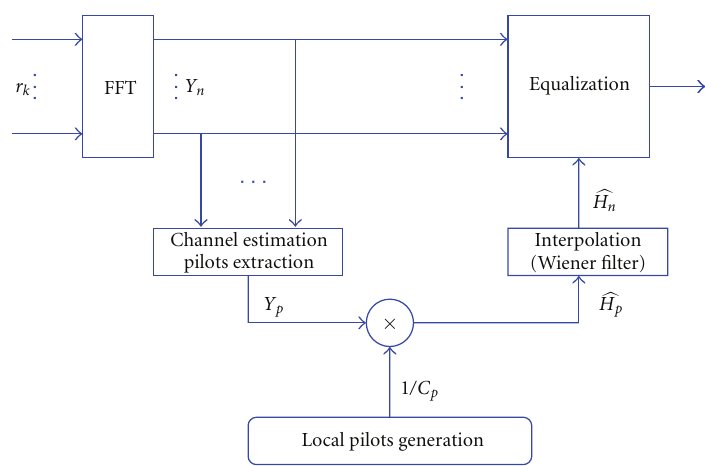
Figure 6: Conventional channel estimation scheme in OFDM systems.